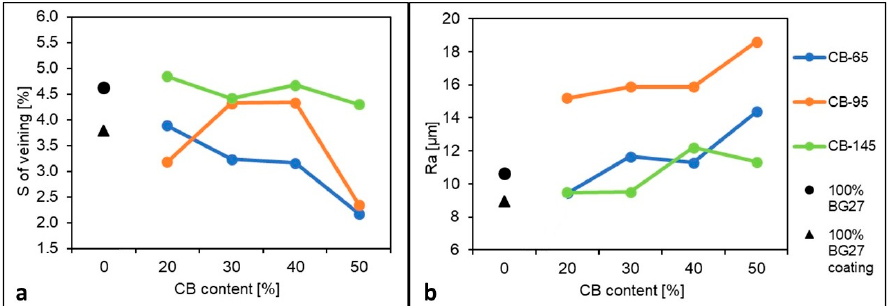
Figure 4. Casting test results: ( a ) resulting surface areas with veining and ( b ) roughness of the cast surface.